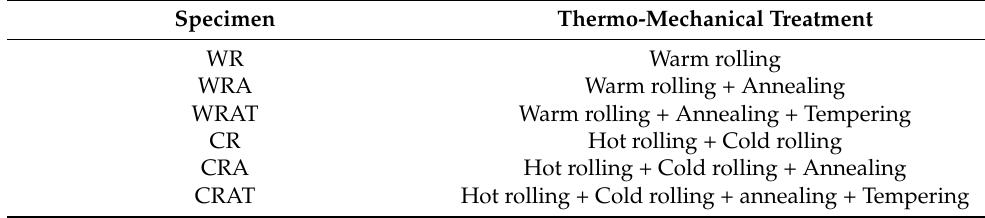
Figure 1. The rolling and heat treatment routes of WR (warm-rolled) specimens and CR (hot-rolled then cold-rolled) specimens. Table 2. The treatment schedules of the MMnS specimens.